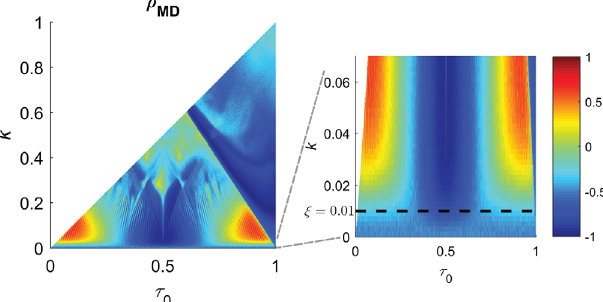
FIG. 7. Mother-daughter correlation ρ as a function of τ 0 and k , with noise level ξ ¼ 0 . 01 and α ¼ − 0 . 5 [as in Fig. 3(b)]. Right: MD Zoom-in on small k ’ s. It can be seen that for k larger than the noise, ρ can become positive, even for negative α . For k below the noise MD level (dashed black line), the forcing features disappear.